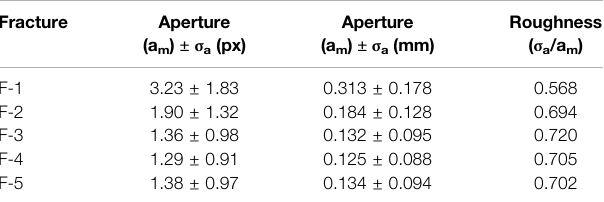
TABLE 1 | Mean apertures and standard deviations (both in px and mm) for the analyzed fractures, and their calculated